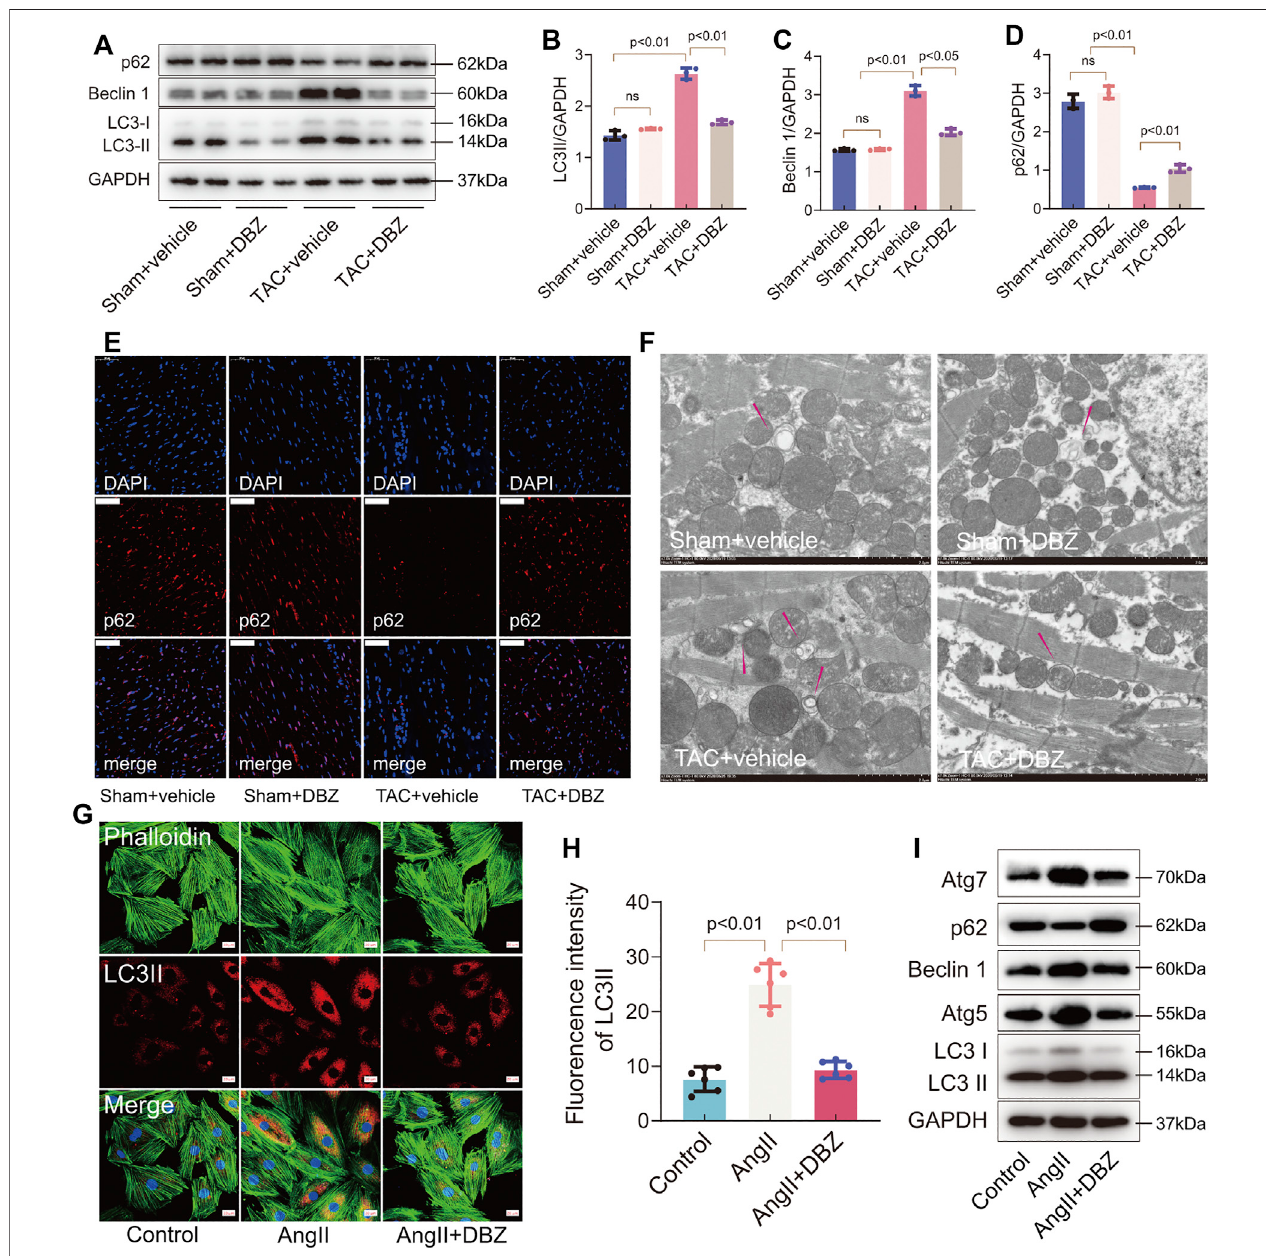
FIGURE 5 | DBZ inhibited stress-induced autophagy. (A – D) Representative Western blotting assay and quanti fi cation of LC3, p62, and Beclin1 expression. n = 3. (E) Immuno fl uorescencestainingofp62incardiactissues.Scalebars=50 μ m. n =3. (F) Representativeelectronmicrographsofautophagicvacuolesincardiomyocytesofratswithvarious treatments.Scalebars=2 μ m. n =3. (G,H) Immuno fl uorescencestainingandquanti fi cationofLC3-IIinNRCMs. n =5.Scalebars=20 μ m. (I) RepresentativeWesternblottingassayof Atg7,p62,Beclin1,Atg5andLC3expression.Resultsareexpressedasmeans±SD.Statisticalanalyseswereperformedbyone-wayANOVAfollowedbyBonferroni ’ s post-hoc